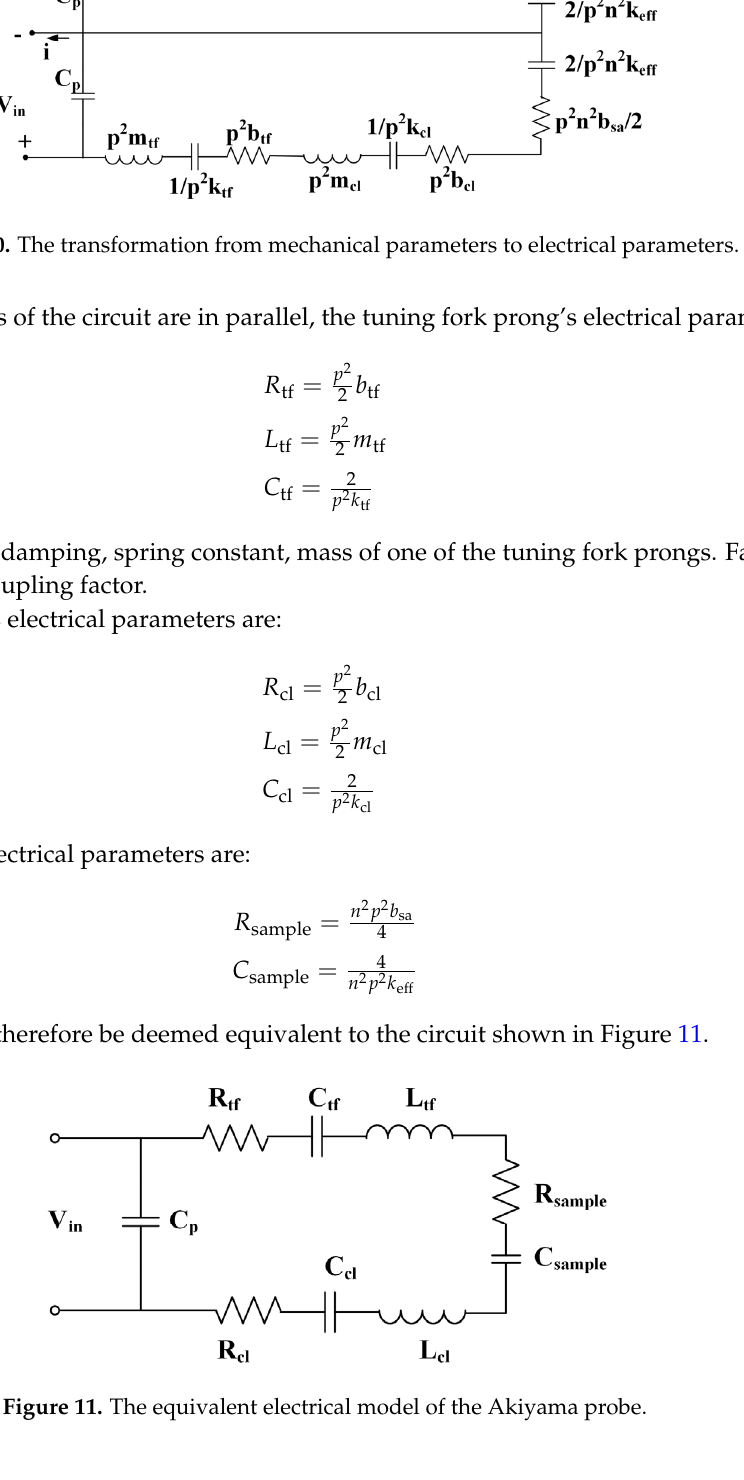
Figure 11. The equivalent electrical model of the Akiyama probe.